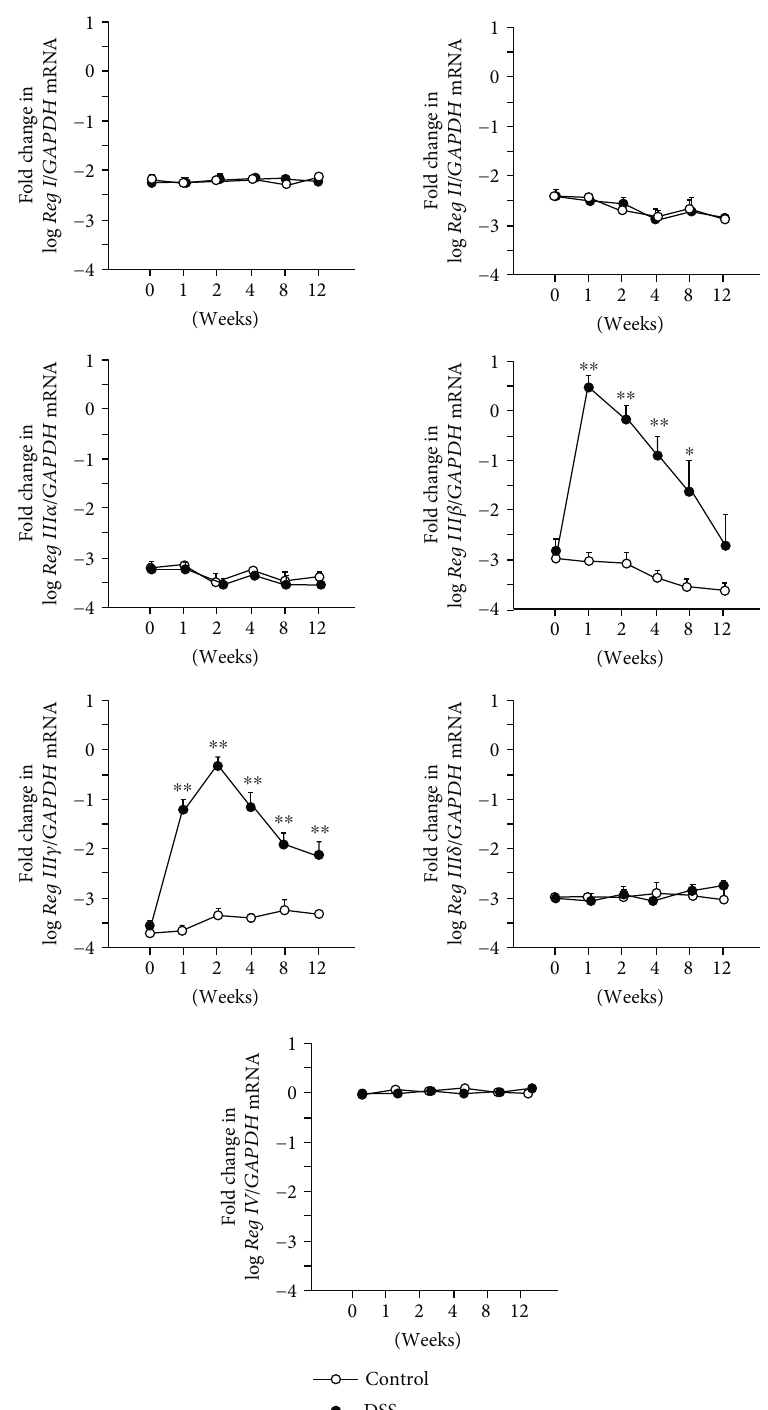
Figure 2: Expression of Reg family mRNA in colonic tissue of mice with DSS-induced colitis. Results are expressed as the mean ± SE . Signi fi cantly greater than in controls at the same time point: ∗ P < 0 : 05 and ∗∗ P < 0 : 01